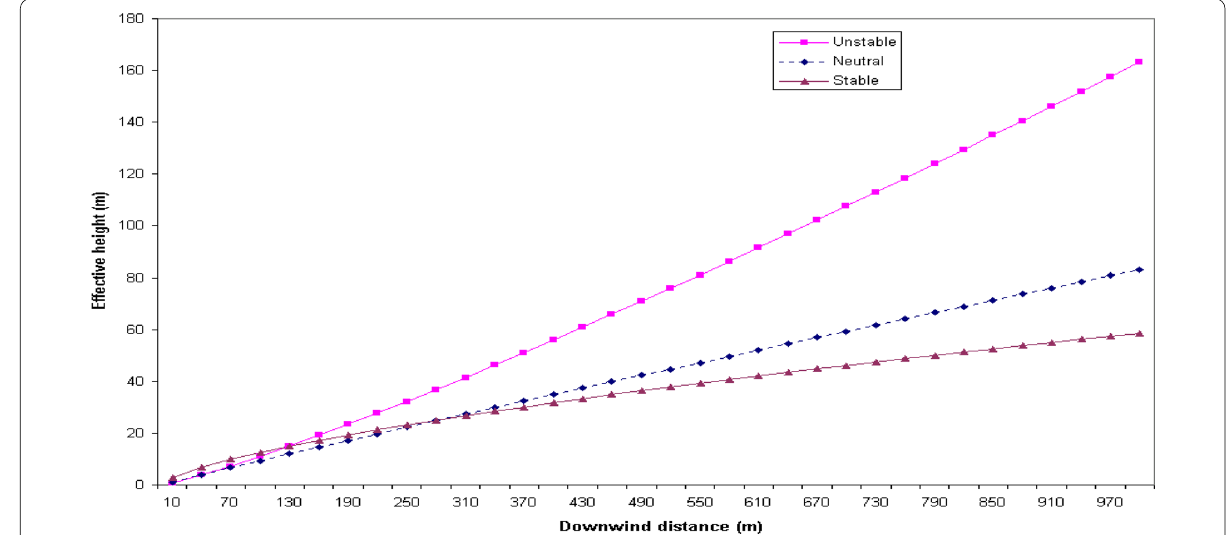
Fig. 10 The variation of (H) for Cs‑137 via (x) when H is a